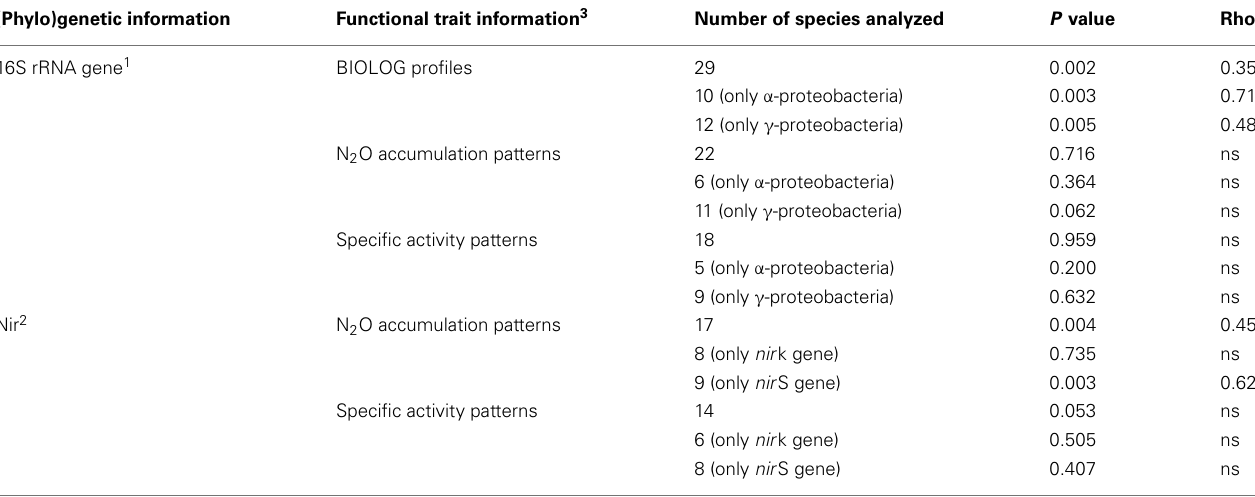
Table 2 | Relationship between (phylo) genetic similarity and functional trait distances among denitrifying strains, as determined by Mantel test. (Phylo)genetic